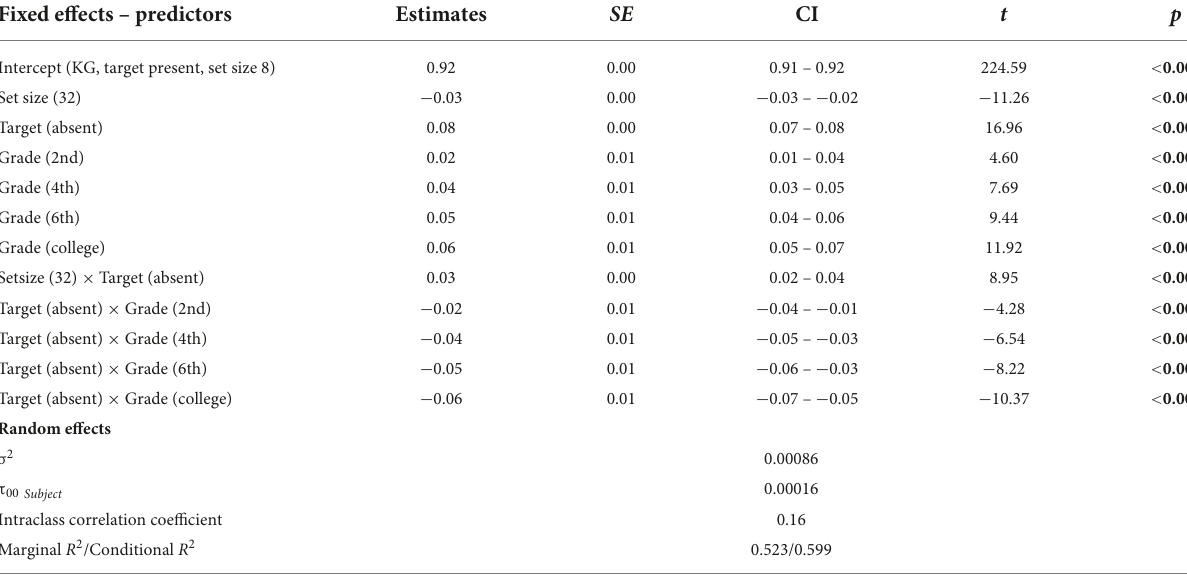
TABLE 7 Estimated coefficients for efficiency score in the visual search